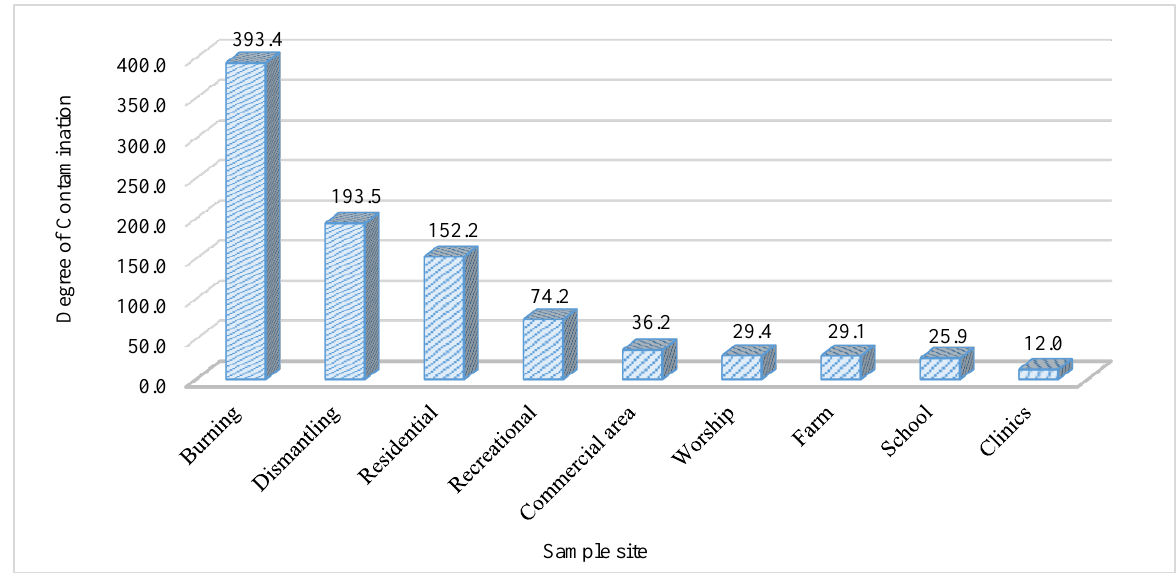
Figure 3. Degree of contamination of heavy metals from the